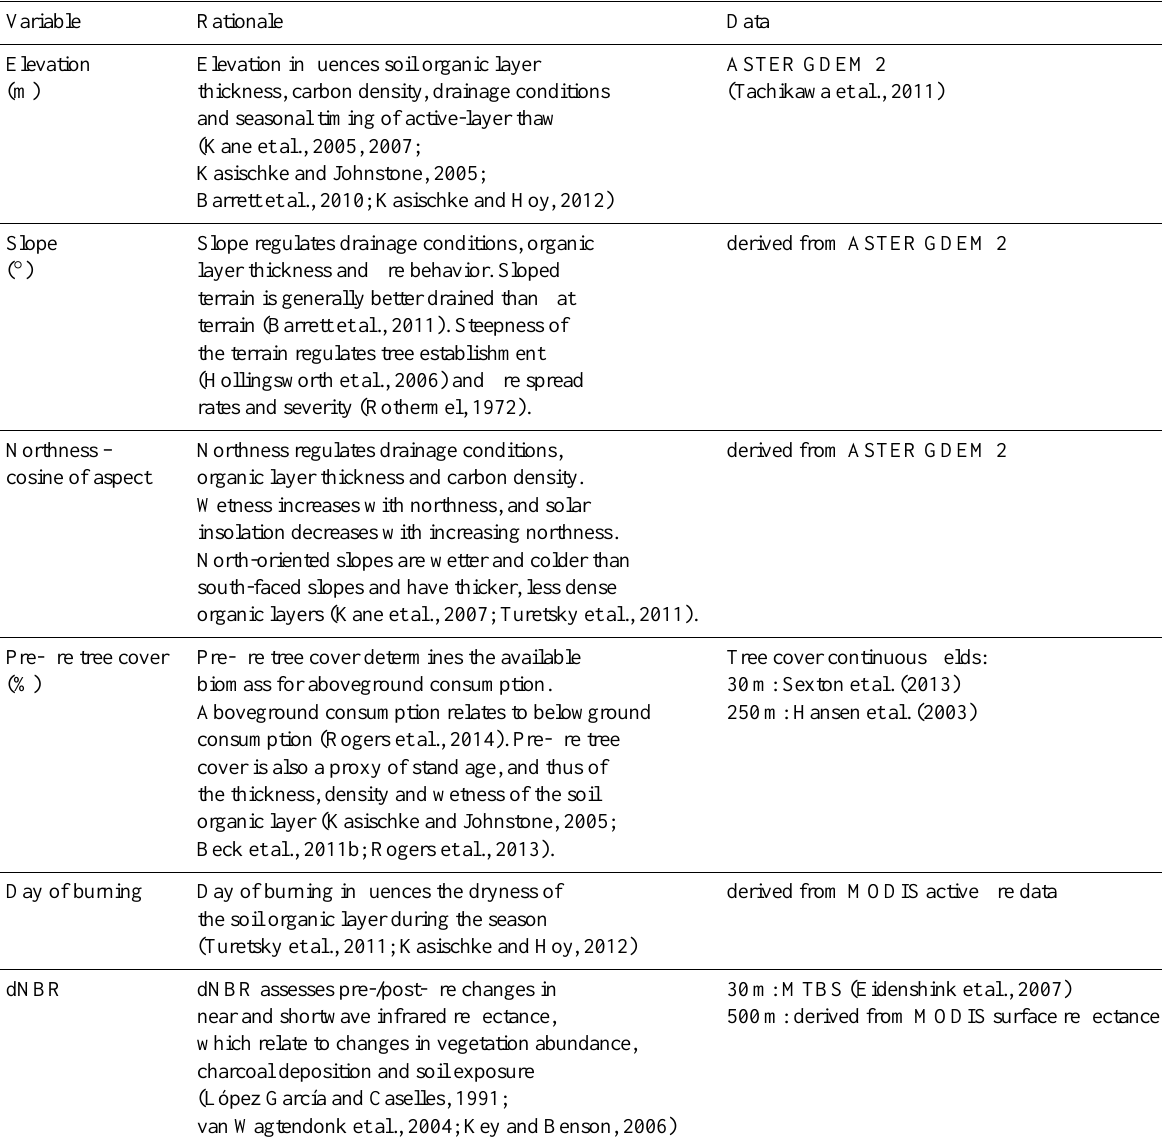
Table 1. Environmental variables selected to predict ground layer consumption by fire in black spruce forest. The pre-fire tree cover and dNBR layers were also used to predict the aboveground carbon